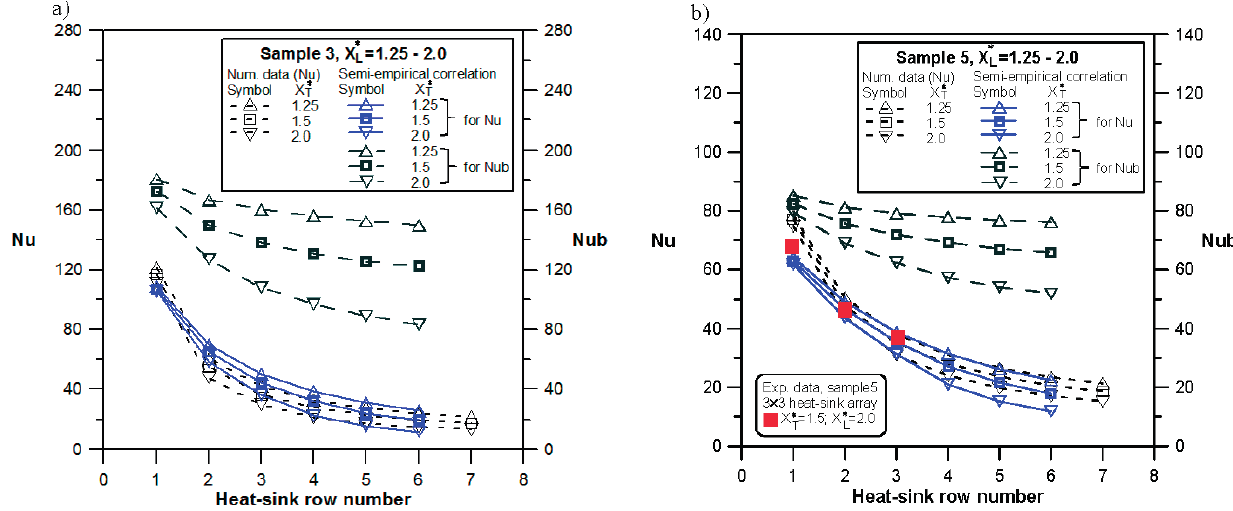
Figure 17. Comparison results of Nusselt number with semi-empirical predictions and experimental data: ( a ) Sample 3 and ( b ) Sample